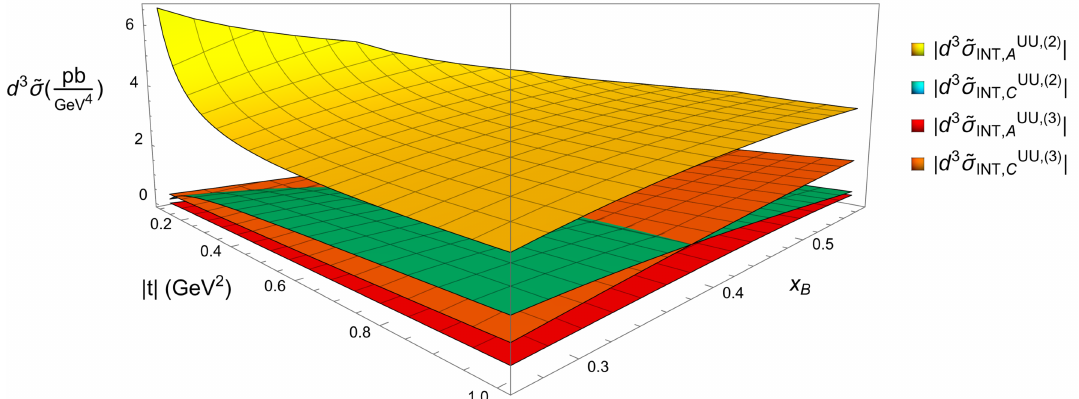
Figure 12 . A comparison of twist-two and twist-three interference cross-section coefficients at JLab 12 GeV kinematics with E = 10 . 59 GeV and Q 2 = 4 GeV 2 . The absolute values are taken for b comparison of the size. The twist suppression for the interference cross-sections works well too, as the leading-twist effect (specifically the top yellow surface) is dominating. Unlike the pure DVCS case, the twist suppression is not affected as x B